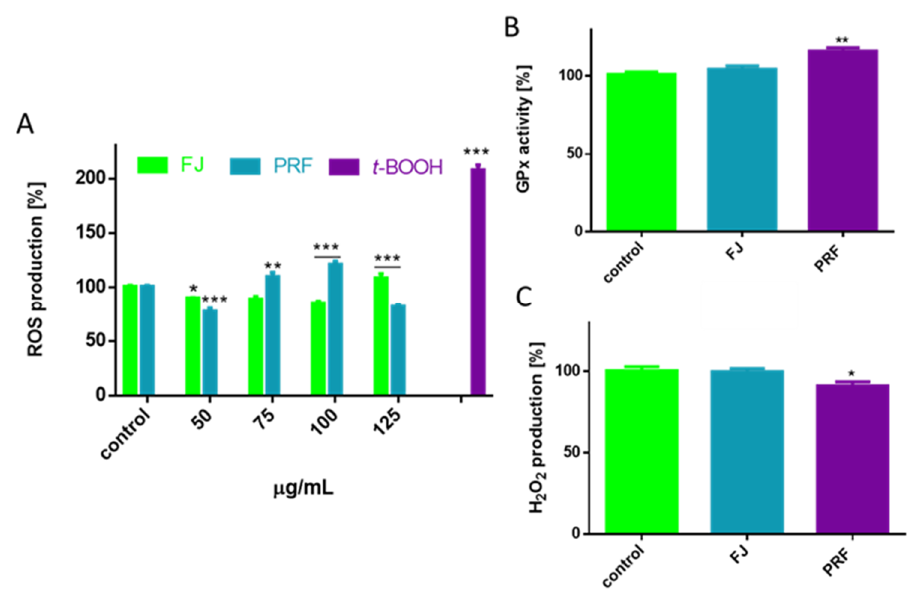
Figure 5. The influence of V. opulus extracts on intracellular ROS generation analyzed by DCFH-DA assay after 24 h incubation of MIN6 cells with FJ and PRF ( A ), GPx activity ( B ) and hydroperoxide production level ( C ). Control cells were not exposed to any compound but the vehicle; values are means ± standard deviations from at least three independent experiments, n ≥ 9; statistical significance was calculated versus control cells (untreated), * p ≤ 0.05, ** p ≤ 0.01, *** p ≤ 0.001.